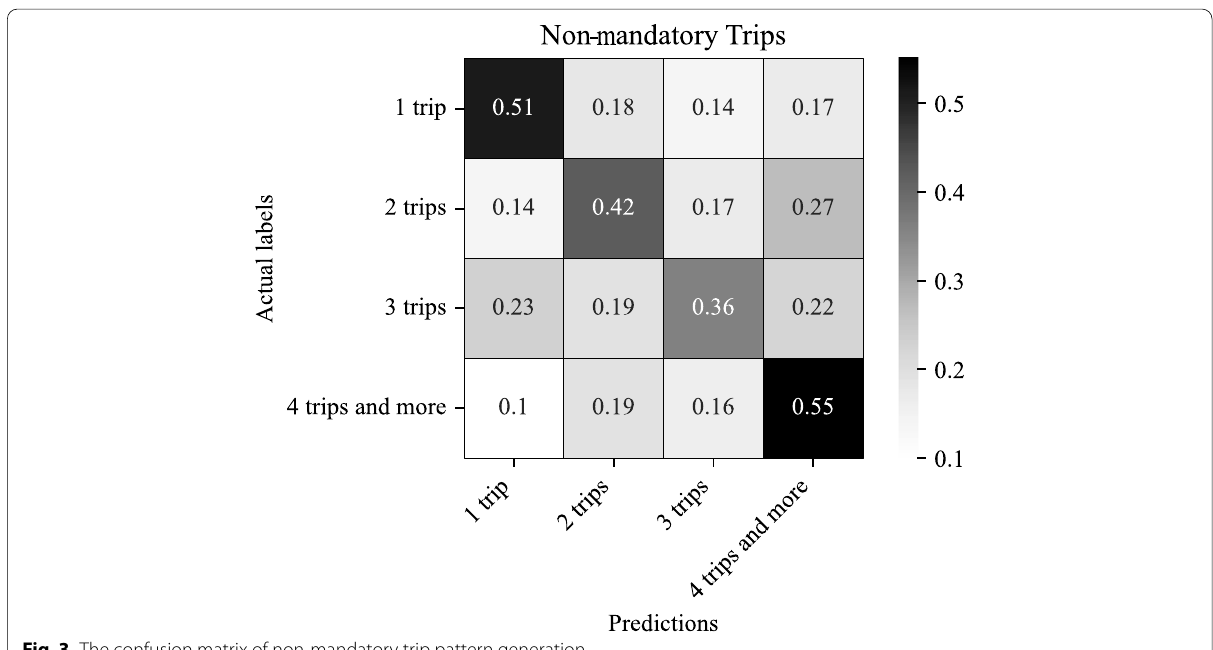
Fig. 3 The confusion matrix of non-mandatory trip pattern generation